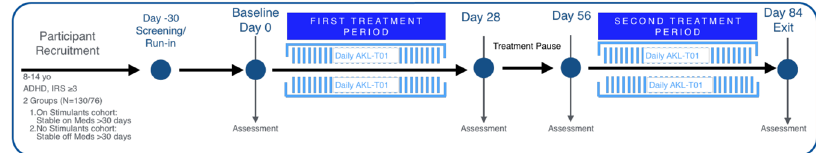
Fig. 3 STARS-Adjunct study overview. The fi gure shows a schematic of the design of the current